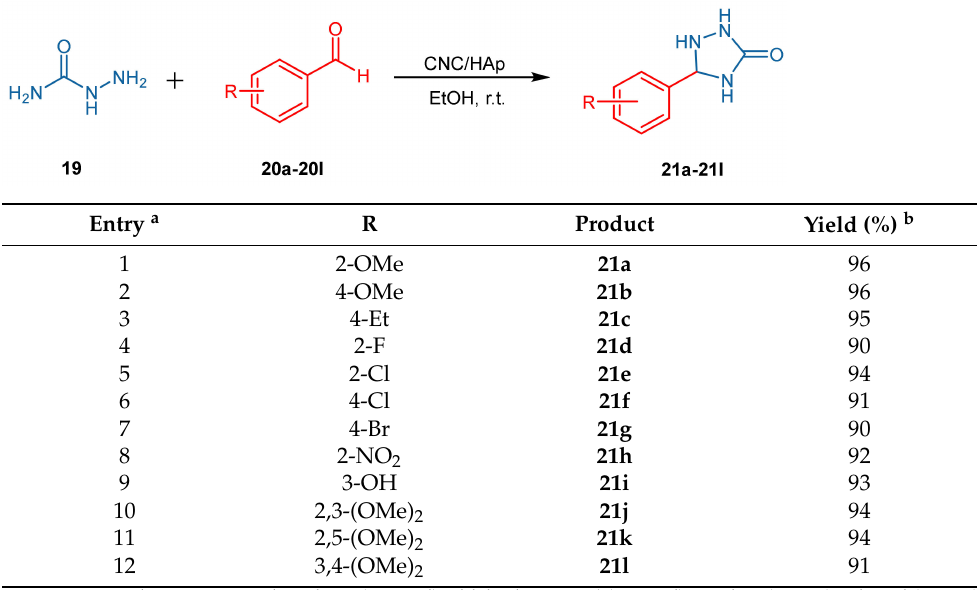
Table 3. Triazolidine-3-one synthesis catalyzed by CNC/HAp.